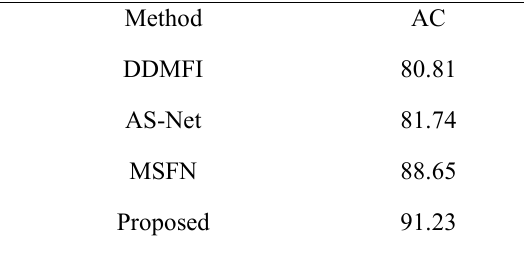
Figure 9. Classification results with different classifiers (%)